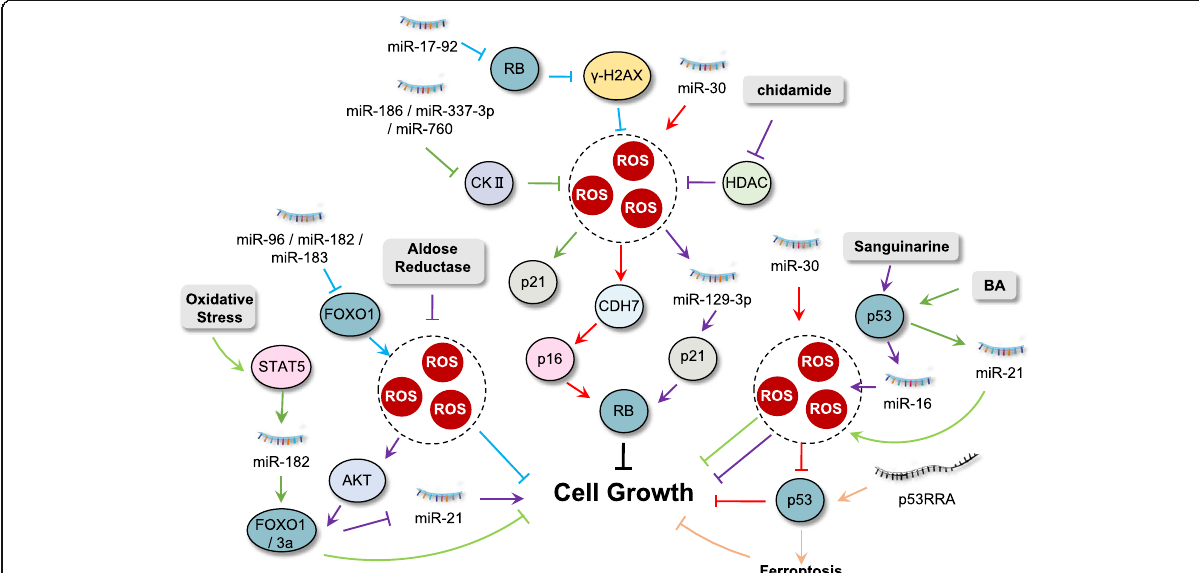
Fig. 2 Interplay between ROS and ncRNAs in evading growth suppression. Tumor suppressor genes, including retinoblastoma (RB) protein, p53 and forkhead box O (FOXO) transcription factors are involved in suppression of cell proliferation, regulated by the interplay between ROS and